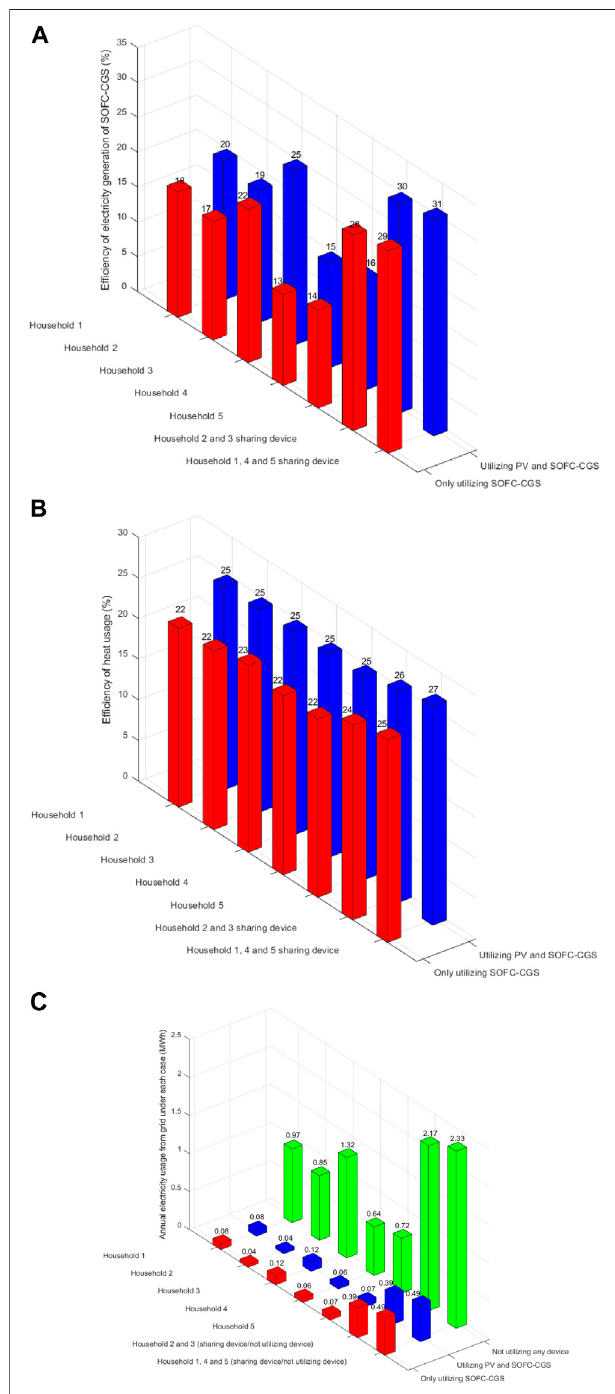
FIGURE 10 | Energy performance of the proposed strategies: (A) electricity production ef fi ciency of the SOFC – CGS for each case, (B) heat usage ef fi ciency of the SOFC – CGS for each case, and (C) annual amount of electricity drawn from the grid for all cases.